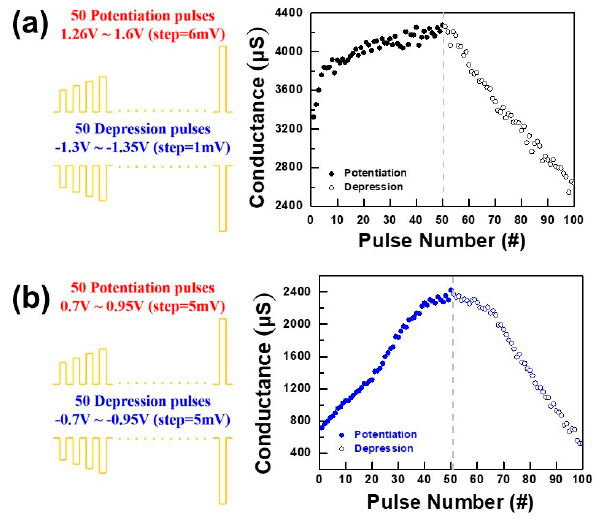
Figure 8. Synaptic plasticity of ( a ) pristine and ( b ) plasma-treated devices.